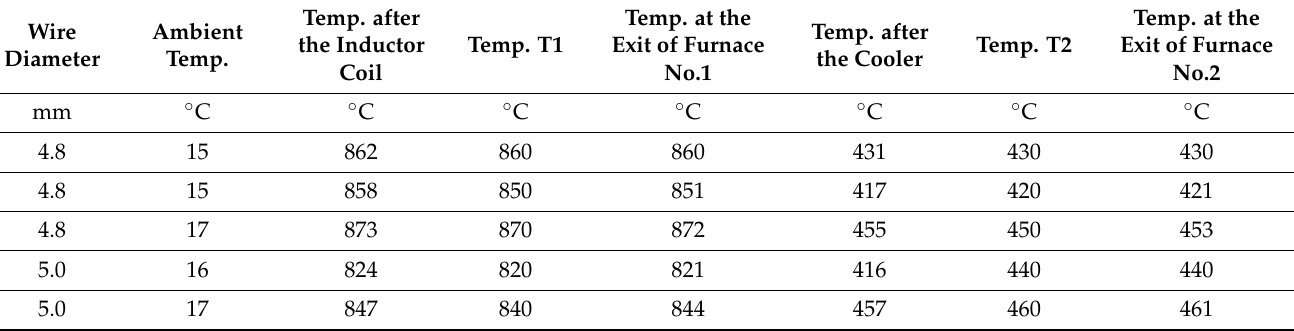
Table 3. Thermally treated wire temperature measurement results for wire speed v = 6.7 cm/s .